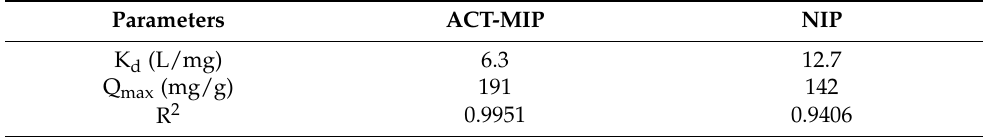
Table 5. The results of Scatchard analysis for ACT by ACT-MIP and NIP.